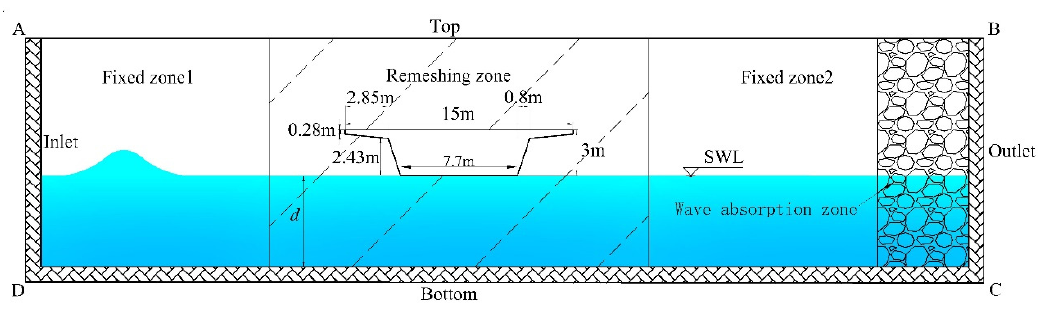
Figure 2. The computational domain and bridge